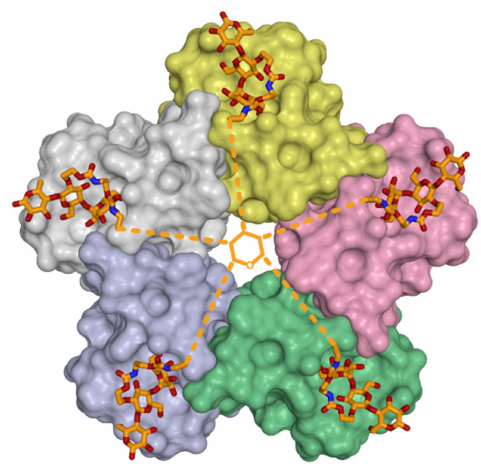
Figure 2. An example of a tailored multivalent inhibitor. The globotriaosylceramide-binding B-subunit of Shiga-like toxin (SLT) forms pentamers and serves as target for the pentavalent inhibitory compound STARFISH, which has been functionalized with the p k trisaccharide. The STARFISH compound exploits the symmetric structure of its target and binds to SLT with a subnanomolar a ffi nity [34]. The SLT pentamer is shown as a protein surface with single protomers colored in grey, yellow, pink, green, and light blue, respectively. The STARFISH compound is shown in stick representation with carbon, nitrogen and oxygen atoms colored in orange, dark blue and red, respectively. Missing parts of the sca ff old structure are schematically indicated as orange lines (PDB ID 1qnu). All protein representations in the figures of this review were generated using PyMOL (Schrödinger